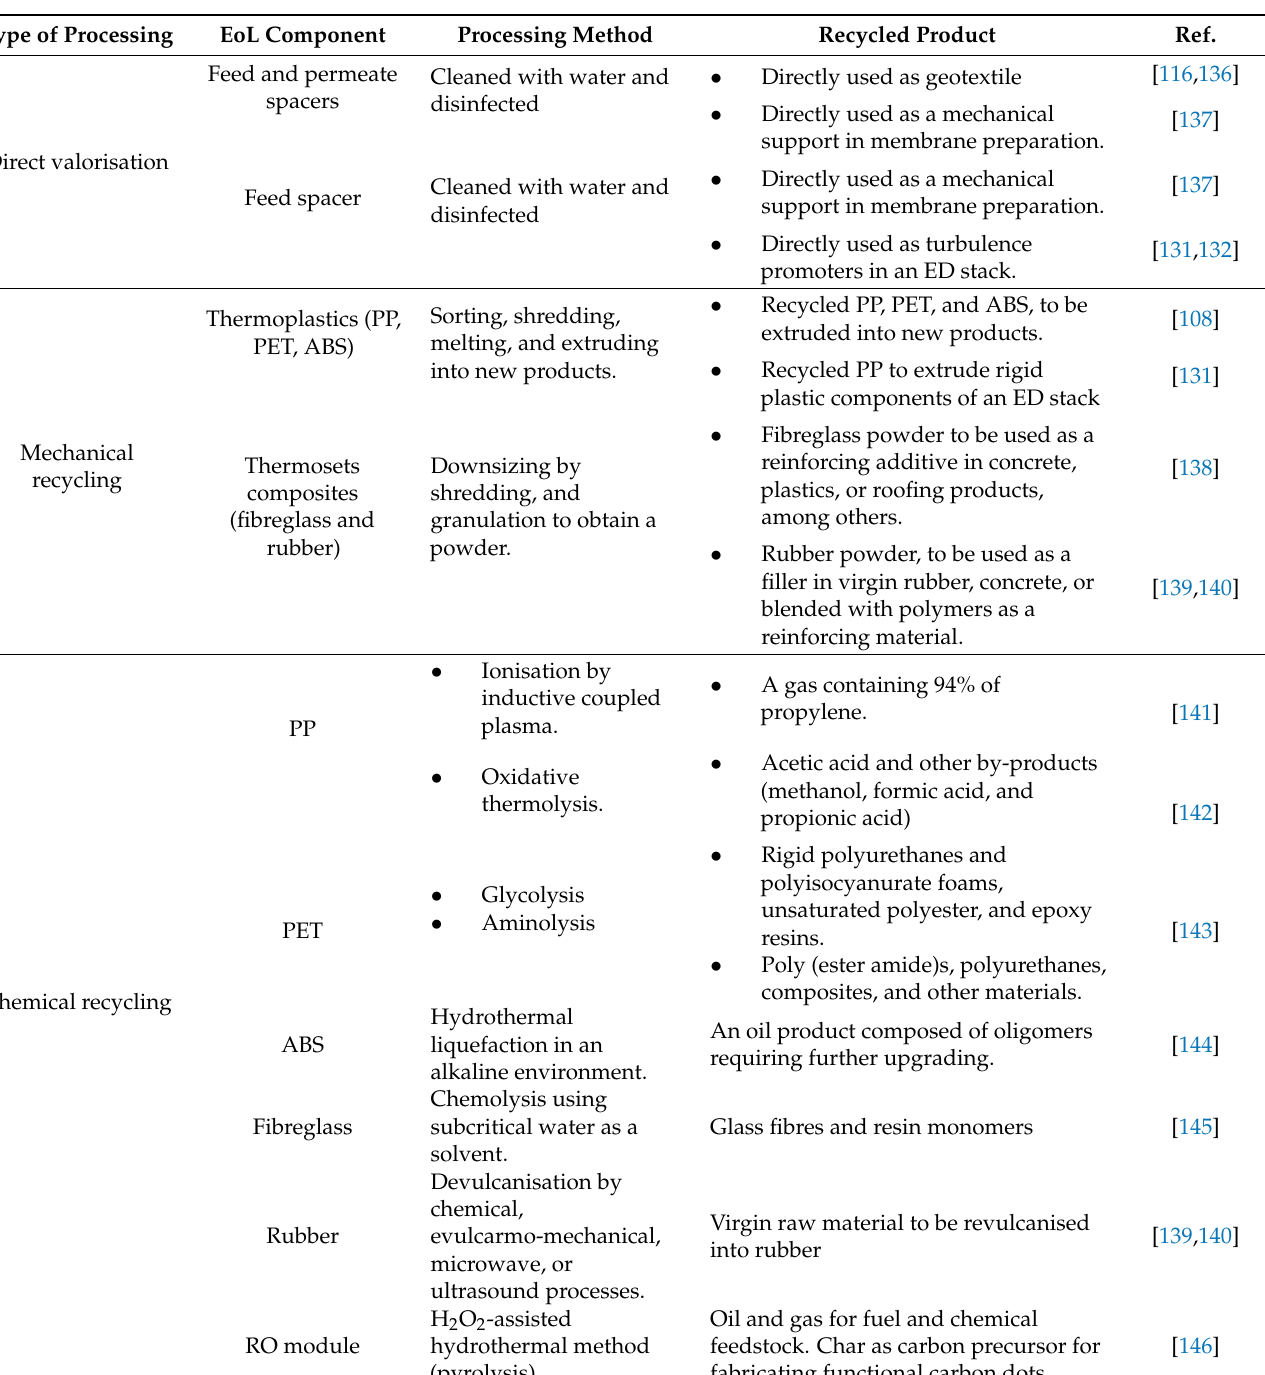
Table 2. Possible routes for the valorisation of plastic components from the EoL RO